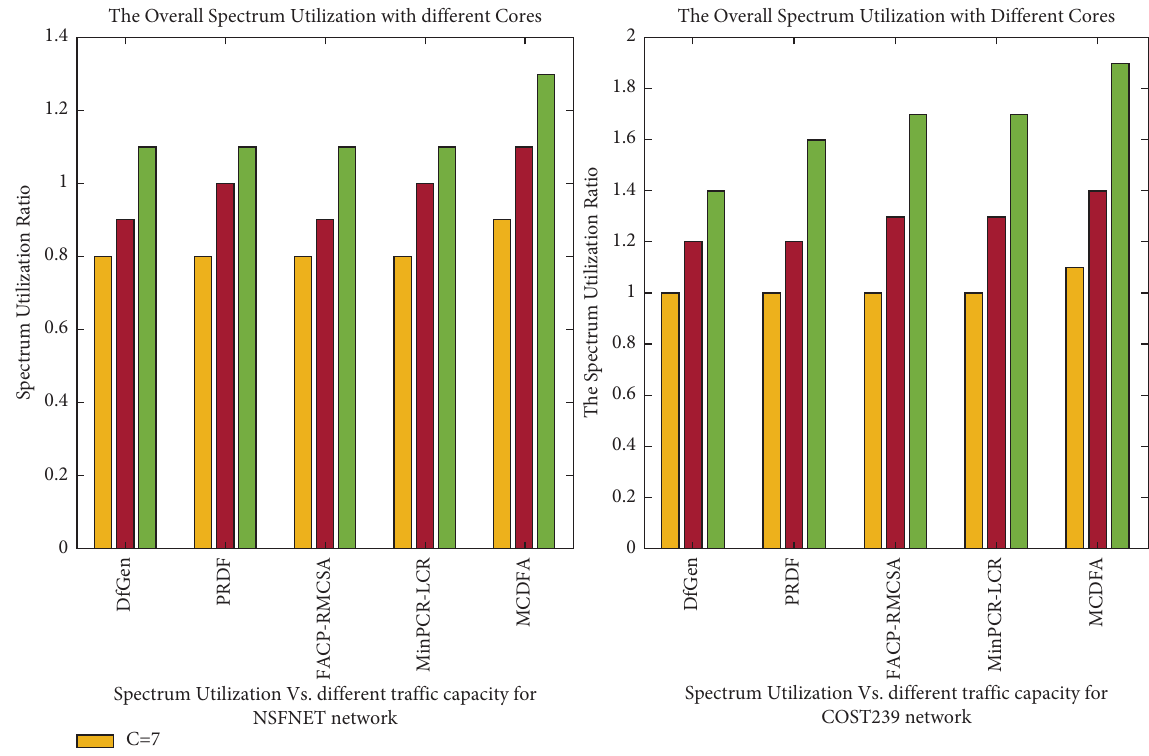
Figure 14: Spectrum utilization vs. diferent trafc capacities for both network Figure 14 depicts overall spectrum utilization proposed algorithm with diferent cores and existing algorithms that considered both NSFNET and COST239 topologies. Tis